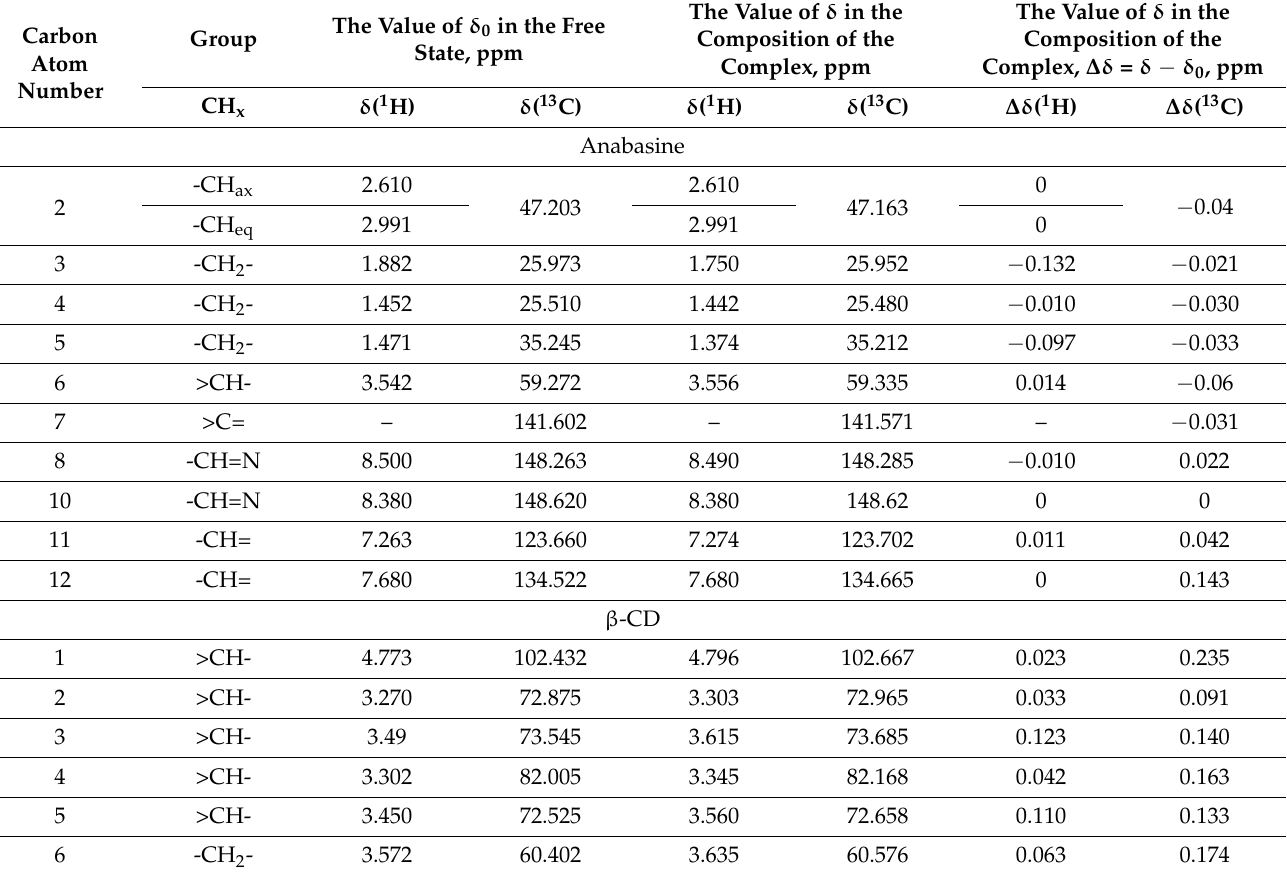
Table 1. Chemical shifts of 1 H and 13 C of anabasine and β -CD in the free state and as part of the